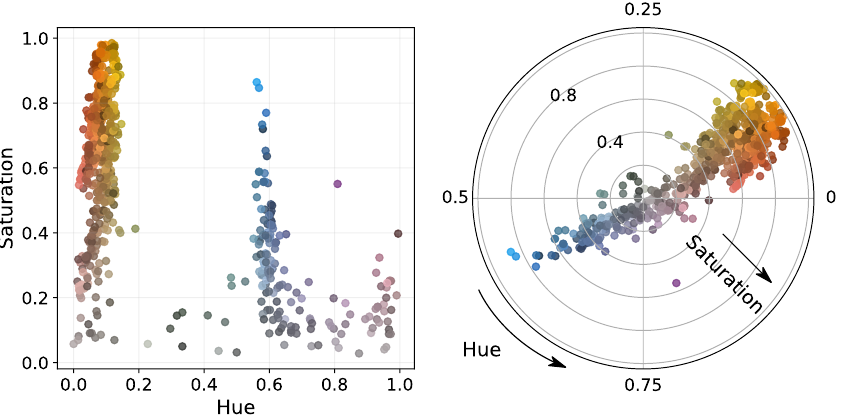
Figure 2. Scatter plot of the colour extracted from the NightUp photos as a function of the Saturation and Hue value, in Cartesian ( left ) and polar ( right ) coordinates. The colour of each point is calculated with the procedure presented in Section